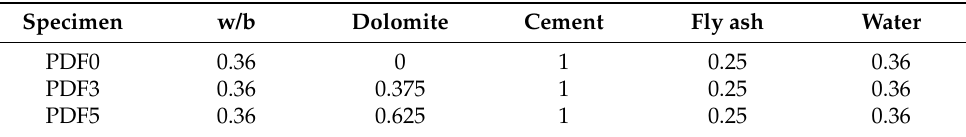
Table 4. Mix proportions of cement pastes (wt.%).